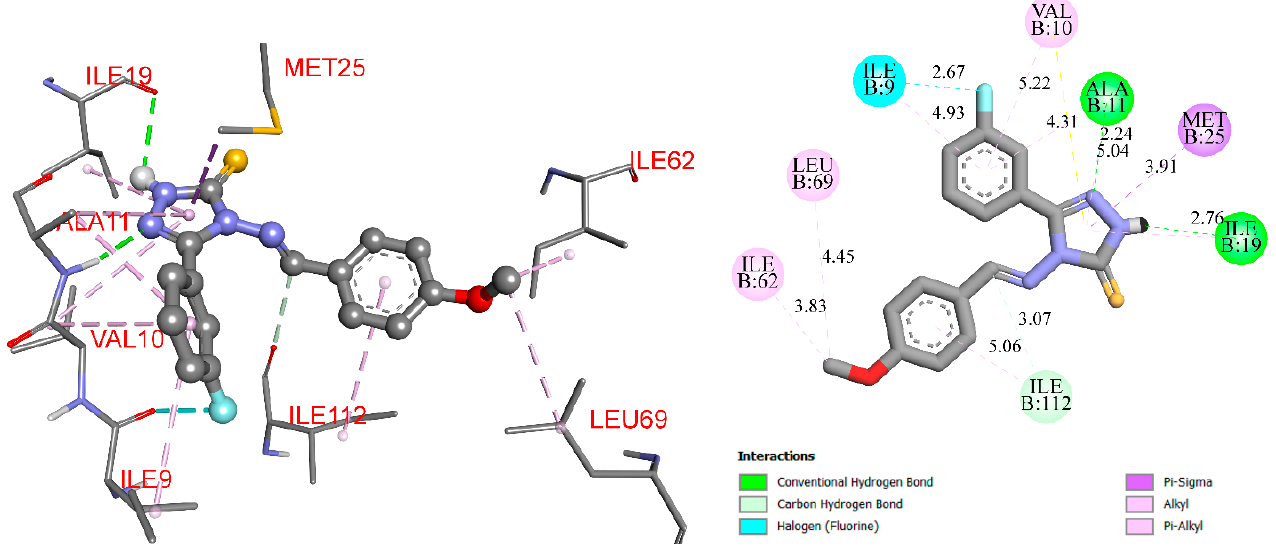
Figure 2. RO4-Dihydrofolate reductase interaction (3D and 2D scheme).